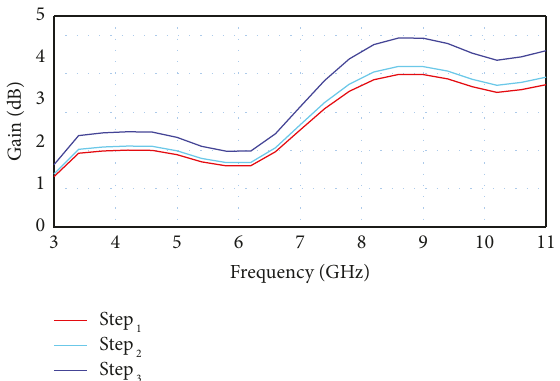
Figure 3: (a–c) Stepwise antenna design frequency vs. gain for all design